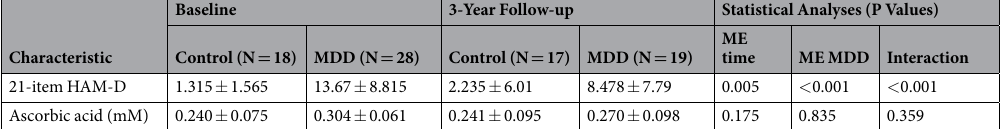
Table 2. HAM-D score and CSF levels of ascorbic acid in subjects at baseline and 3-year follow-up. The data are the mean ± standard deviation (S.D.). MDD: Major depressive disorder, 21 HAM-D: 21-item Hamilton Depression Rating Scale. Analysis = 2 × 2 Repeated multivariate analysis of variance (MANOVA). ME time = Main effect of time (baseline and follow up), ME MDD = Main effect of MDD-status (depressed and controls).